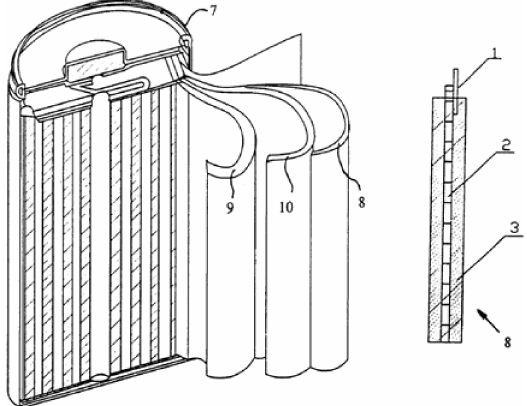
Figure 15. Schematic diagram of a special current collector design with 1: tap, 2: substrate, 3: metal hydride powder, 7: can, 8: negative electrode, 9: positive electrode, and 10: separator [194].